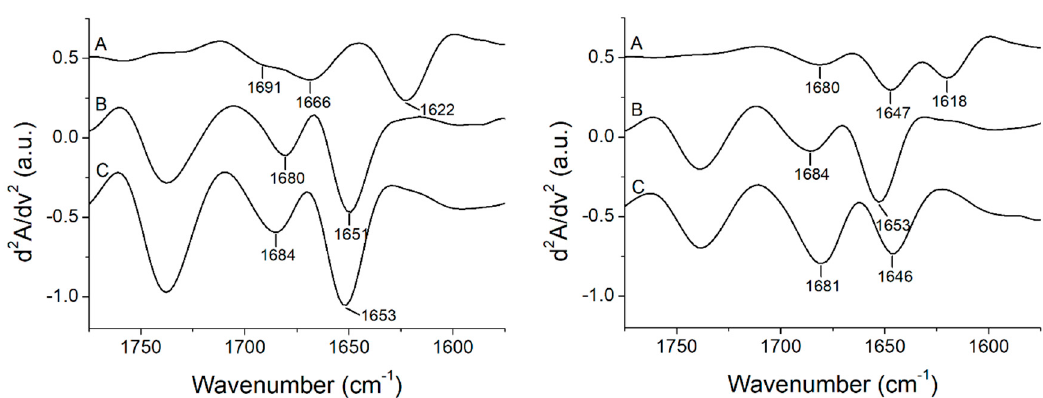
Figure 5. Stacked second derivative spectra of the peptide + 2 ( left ) and + 5 ( right ) in the absence of lipids (A) and in the presence of multilamellar vesicles of POPC (B) and POPC / POPG (C). The spectra are reported in the 1775–1575 cm − 1 region to show the spectral range of both the lipids’ carbonyl group and the peptides’ amide I’ bands.